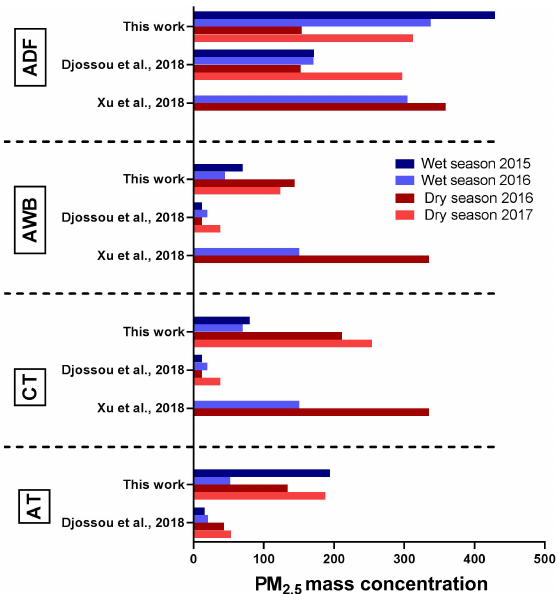
Figure 7. Comparison of PM 2 . 5 mass concentrations in micrograms per cubic meter (µgm − 3 ) at the four sites with those obtained by Djossou et al. (2018) and Xu et al. (2019) for the same sites and periods. Data for the following weeks were then selected in Djossou et al. (2018): 20–27 July 2015 for WS15, 4–11 January 2016 for DS16, 4–11 July 2016 for WS16, and 9–16 January 2017 for